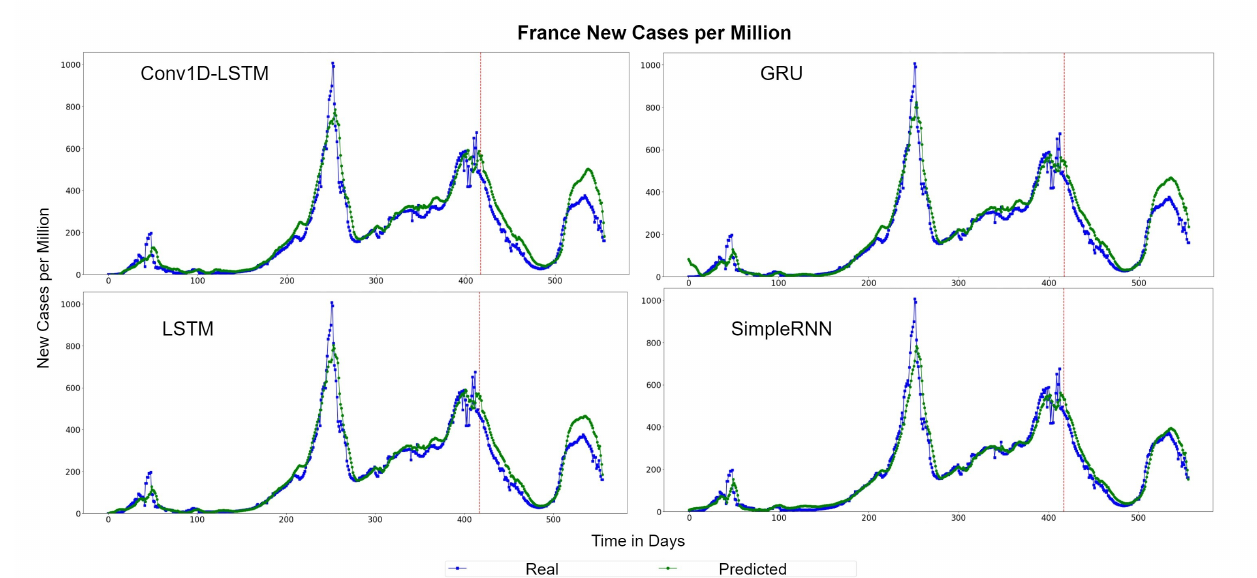
Figure 8. France new cases per million real (blue line) and predicted (green line) values for each method, using the training, validation, and test datasets. The red line divides the train-validation (right size) and the test (left side)